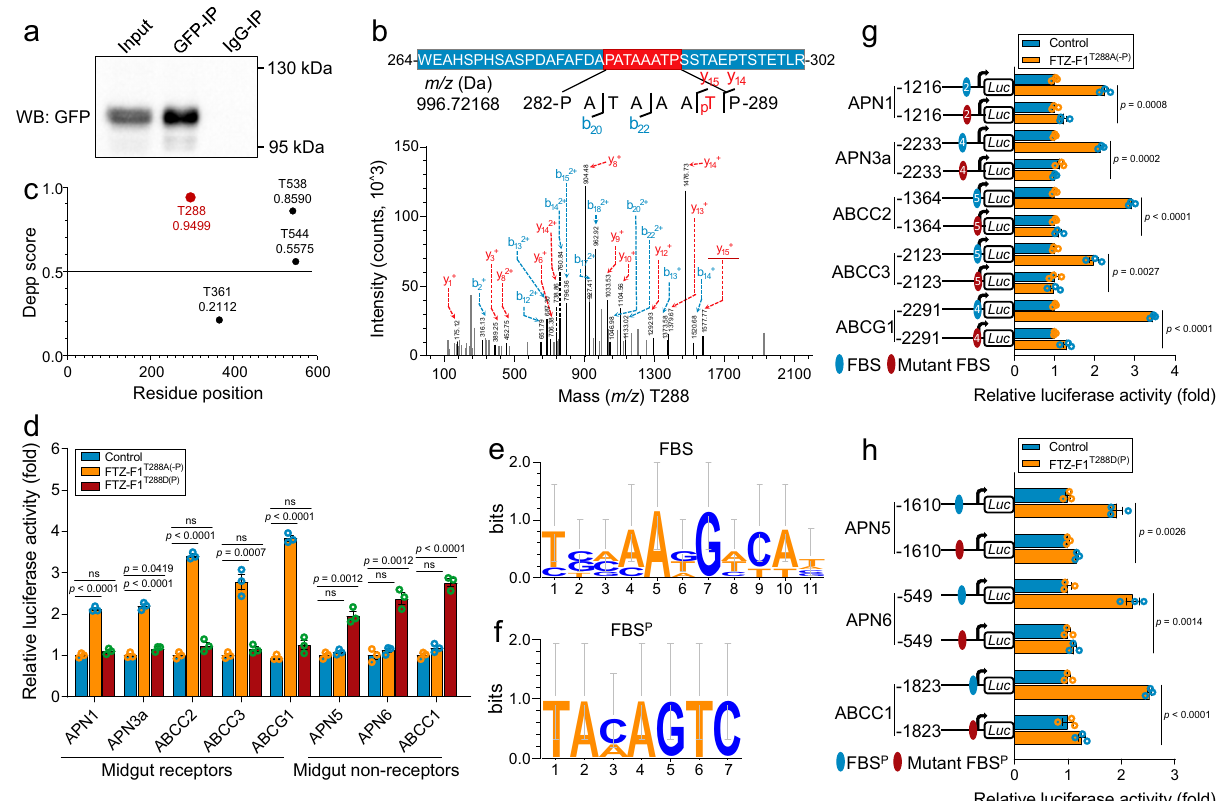
Fig. 3 | Identi fi cation of the functional phosphorylation sites for FTZ-F1. a Immunoprecipitation of exogenous FTZ-F1 from Sf9 cells using anti-GFP. b The putative phosphorylation site T288 of FTZ-F1 was identi fi ed by LC-MS/MS. The precursor ion, which ranges from 264 to 302, is shown in the top band with the amino acids in white letters, and the representative fragment ion is shown with a red background with detailed information. The identi fi ed phosphorylation site T288 is represented by a red letter and subscripted p, while the phosphorylated peptideonthespectrumisunderlinedinred. c TheDEPPscoreofthefourputative phosphorylation sites was computed using the DEPP software in silico. d The regulatory effect of phosphorylated FTZ-F1 T288D(P) and non-phosphorylated FTZ-F1 T288A(-P) onmidgutgenes.AsubstitutesTmimickingdephosphorylationandD